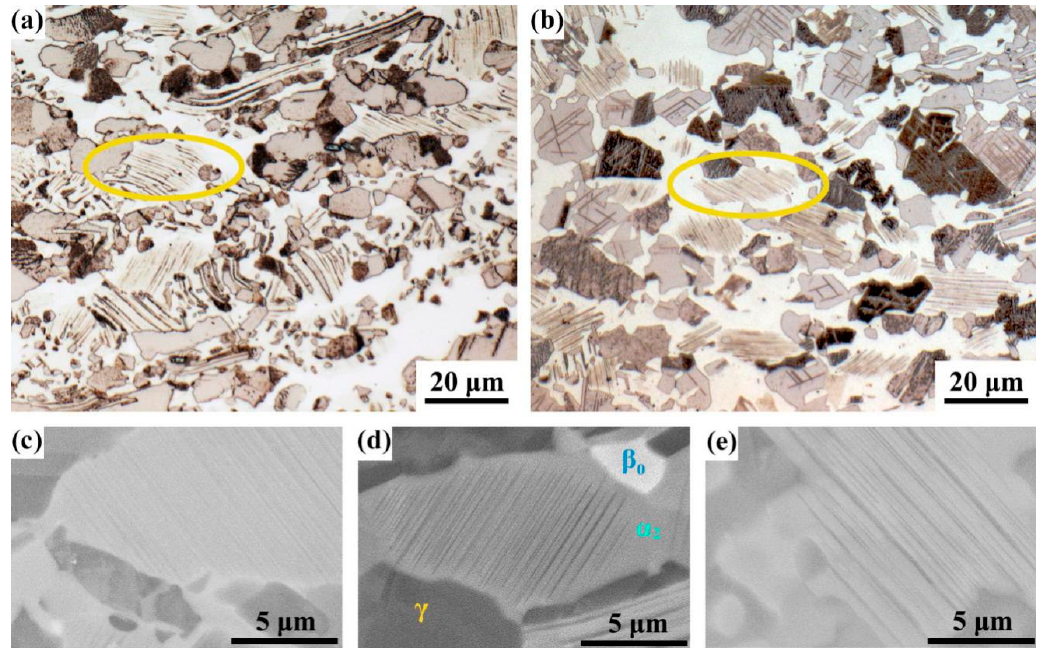
Figure 4. Light microscope (LM) images ( a , b ) and BSE images ( c – e ) of newly precipitated lamellae in the forged samples of HT-1 ( a , d ), HT-24 ( b , e ) and sample with no heating process ( c